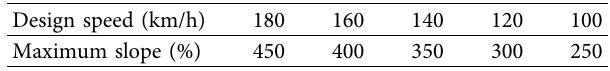
Table 8: Minimum lengths of superhighway slopes.